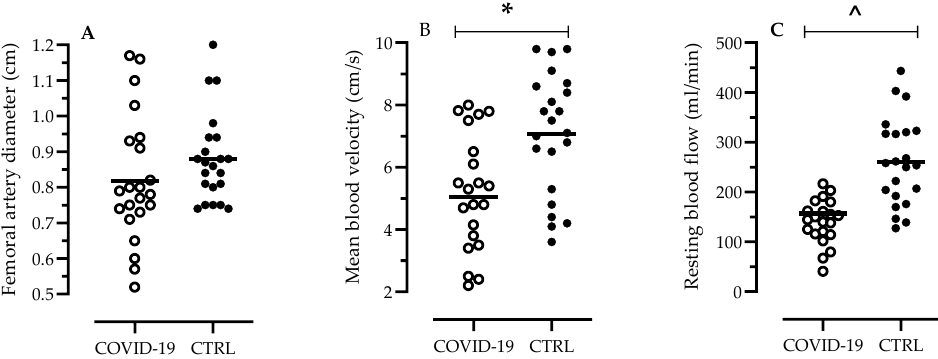
Figure 1. Femoral artery diameter ( A ), blood velocity ( B ) and femoral blood flow ( C ), at rest in COVID-19 patients ( n = 22) versus age- and sex-matched controls (CTRL, n = 22). Data are presented in a scatter plot, and black bars indicate the mean value; * refers to p = 0.001, ^ refers to p < 0.001.